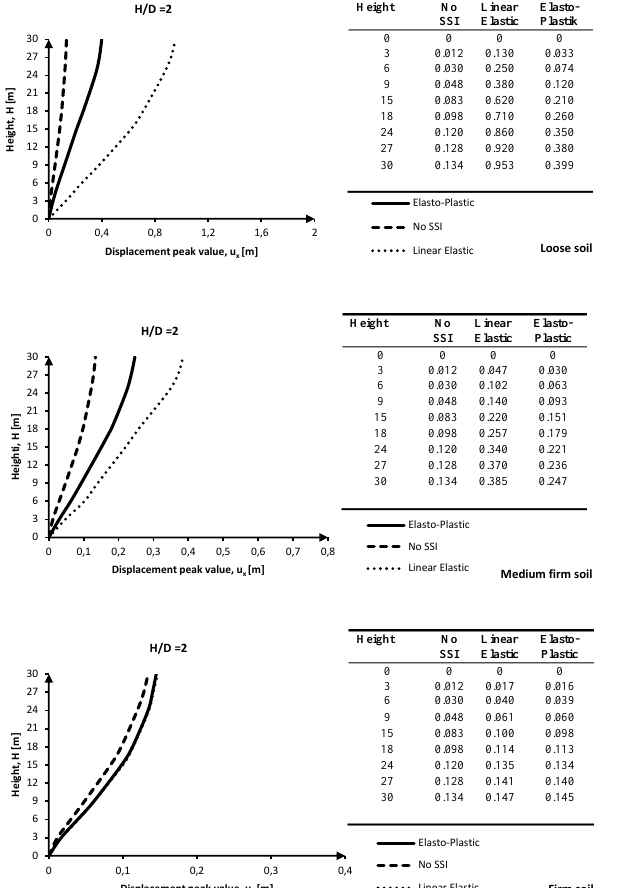
Fig. 5. Variation of peak lateral response of the building depending on different soil conditions in the case of H/D = 4 for the 1989 Loma Prieta earthquake input motion.